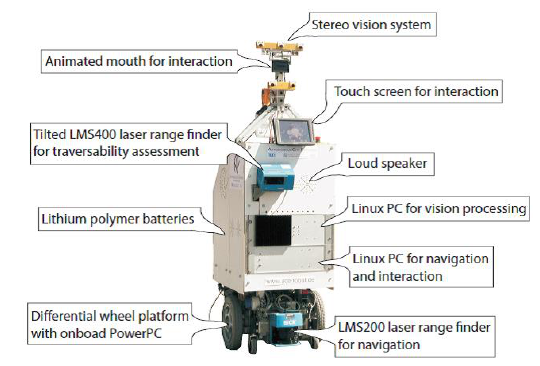
Figure 6: The Autonoumous City